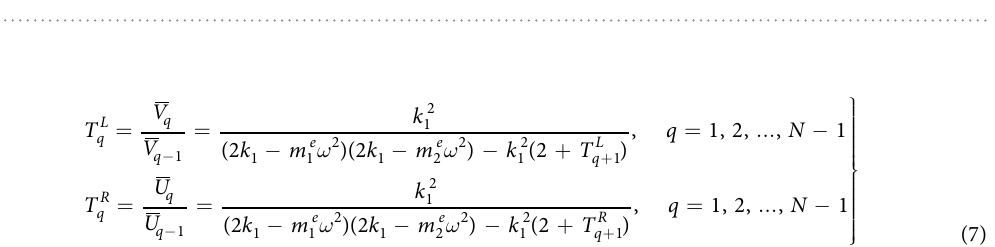
Table 1. Material properties in continuum rod